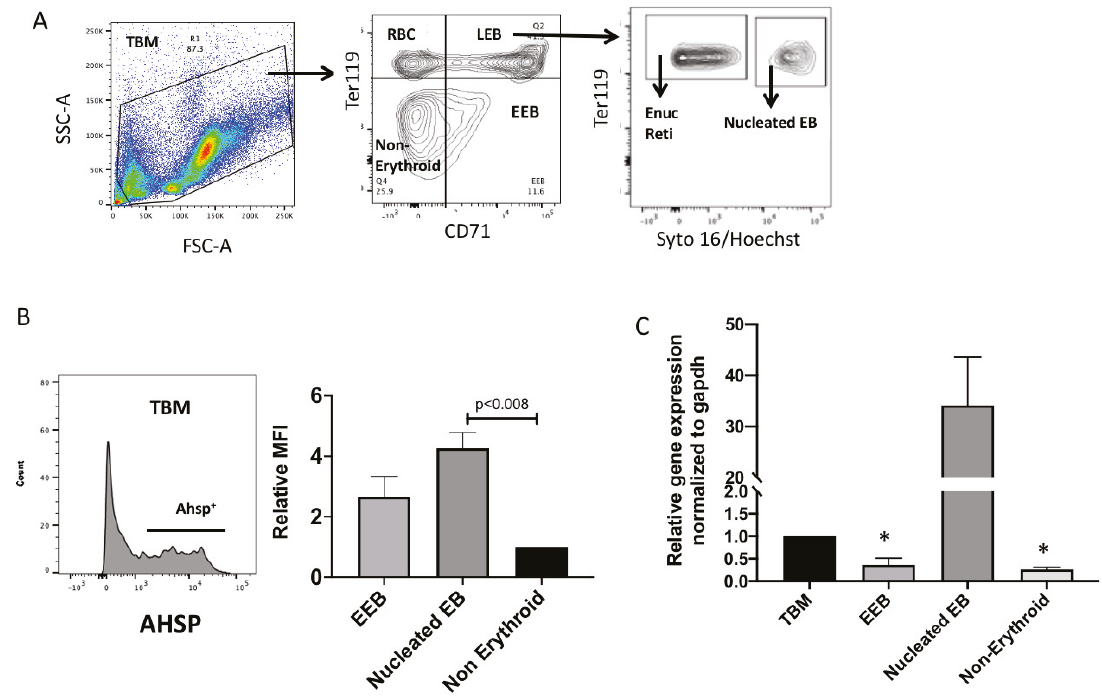
Figure 3. AHSP protein and gene expression from in vivo mouse bone marrow. ( A ) Exemplary flow cytometry gating of bone marrow, harvested from mice, stratified into total bone marrow (TBM), non-erythroid cells, early erythroblasts (EEB), red blood cells (RBC), late erythroblasts (LEB), enucleated reticulocytes (Enuc Reti) and nucleated erythroblasts (EB). ( B ) Intracellular AHSP protein expression of murine bone marrow in TBM, EEB, nucleated EB and non-erythroid subsets. ( C ) Relative gene expression of AHSP in bone marrow cells from flow sorted subsets as shown in A. Bar graphs represent fold change compared to TBM. Target gene cycle threshold (Ct) values were normalized to GAPDH Ct values using the ∆∆ Ct method. * p < 0.05 vs. TBM; n =